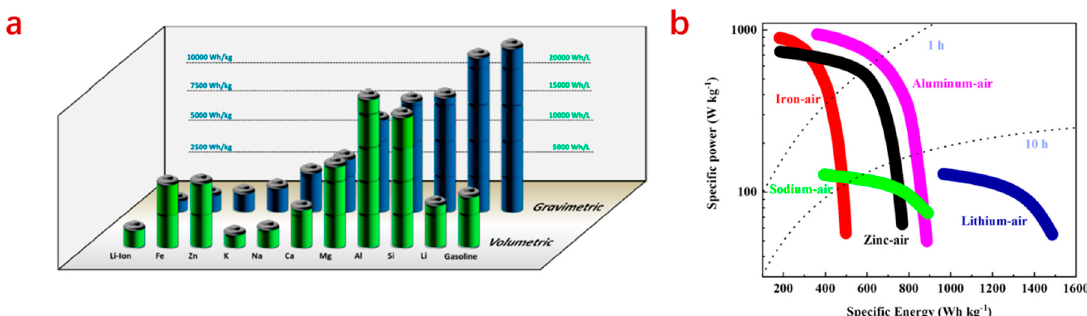
Figure 1. Theoretical energy of various metal–air batteries (excluding oxygen uptake) ( a ) and the Ragone plots for some important and established metal–air batteries ( b ) [11].